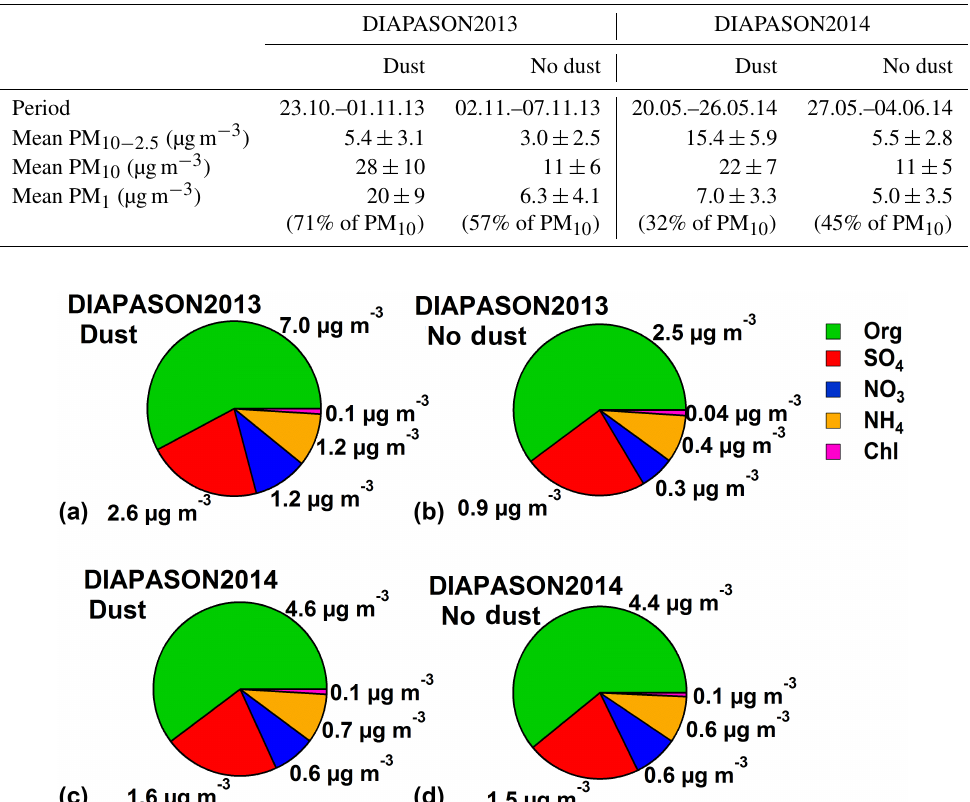
Figure 4. Comparison of mean chemical composition of non-refractory PM 1 obtained from AMS measurements during dust (left) and no dust (right) periods during DIAPASON2013 (top) and DIAPASON2014 (bottom).